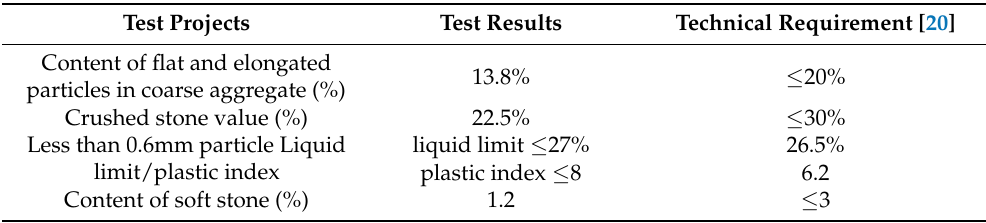
Table 4. Technical indicators of